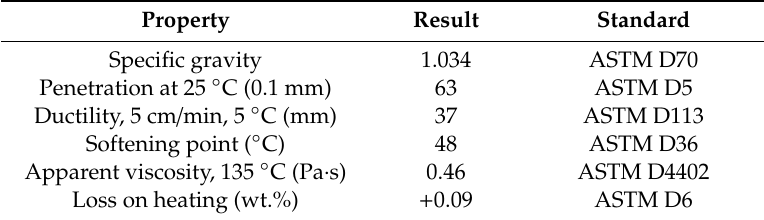
Table 1. Fundamental properties of Pen60 / 80 asphalt binder.